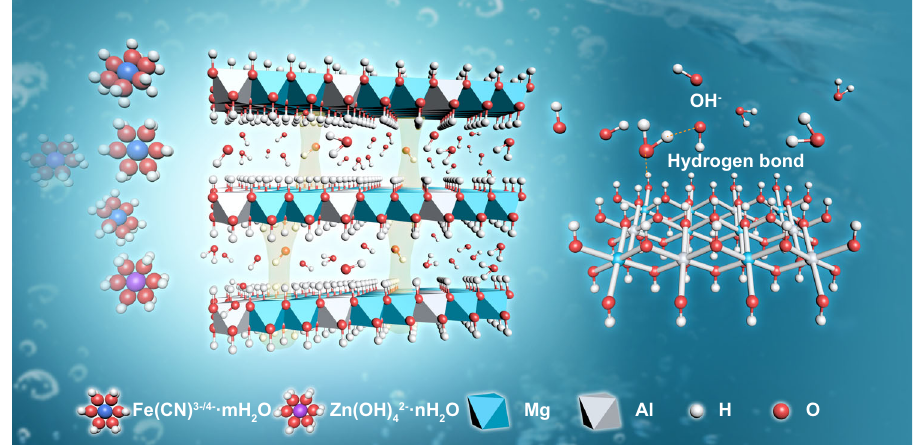
Fig. 1 Selective ions transport and the hydroxide ions transport mechanism for LDHs. The well-de fi ned interlayer spacing of LDHs plays an important role in selective ions transport. The strong hydrogen bond network in the gallery of LDHs is expected to facilitate the effective conduction of hydroxide ions.